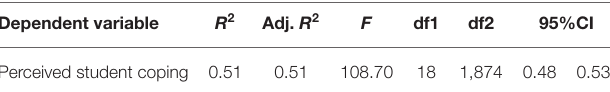
TABLE 4 | The regression results of the effects of indicators of teacher professional and personal adaptation to remote teaching on the perception of student coping with online